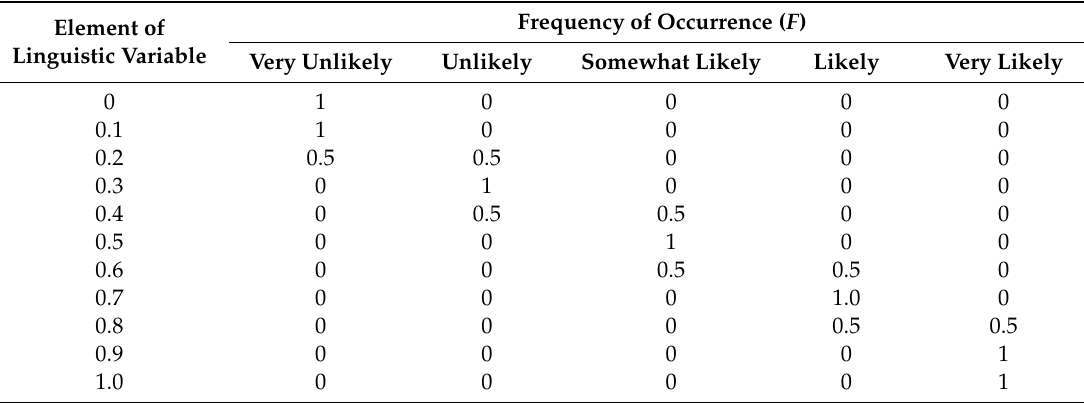
Table 10. New membership function for frequency of occurrence ( F ).